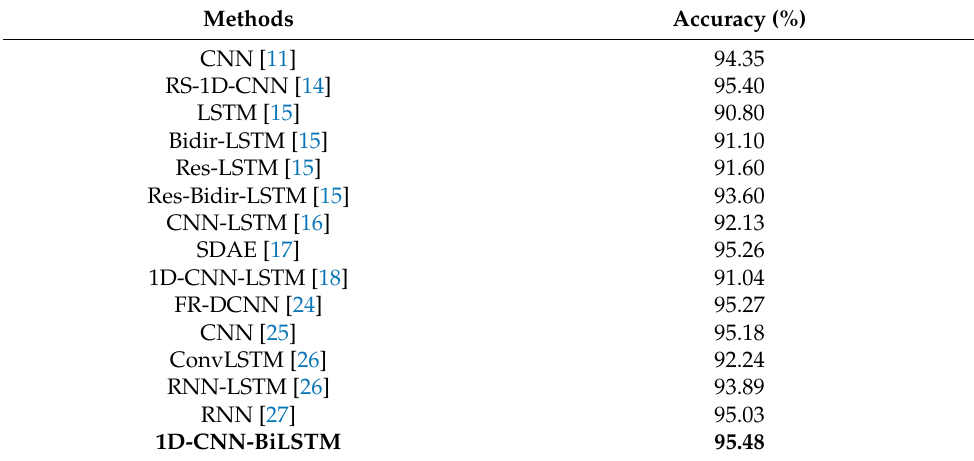
Table 8. Comparative results on the UCI-HAR dataset.